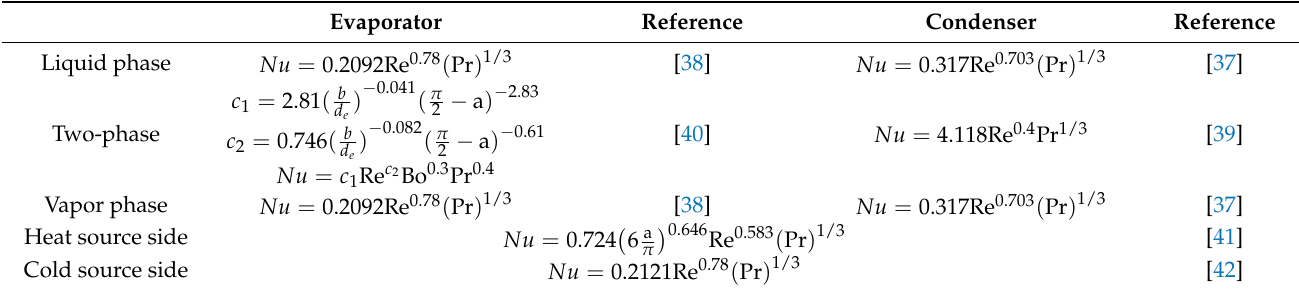
Table 3. The heat transfer correlations used in the